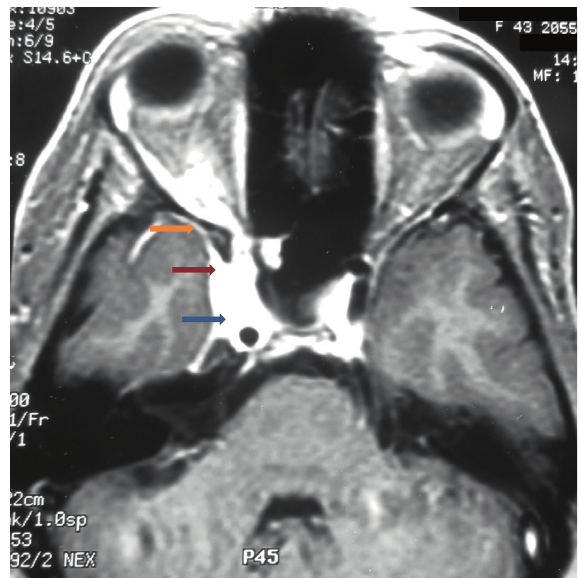
Figure 1: Axial sequence, after contrast, in T1, showing expansive, extra-axial, parasellar lesion, with intense enhancement after contrast infusion, involving the cavernous sinus and the carotid, without compromising their diameters (blue arrow); the lesion involves the apex of the orbit (red arrow), and there is thickening and enhancement of the dura mater (yellow arrow), suggestive of meningioma.